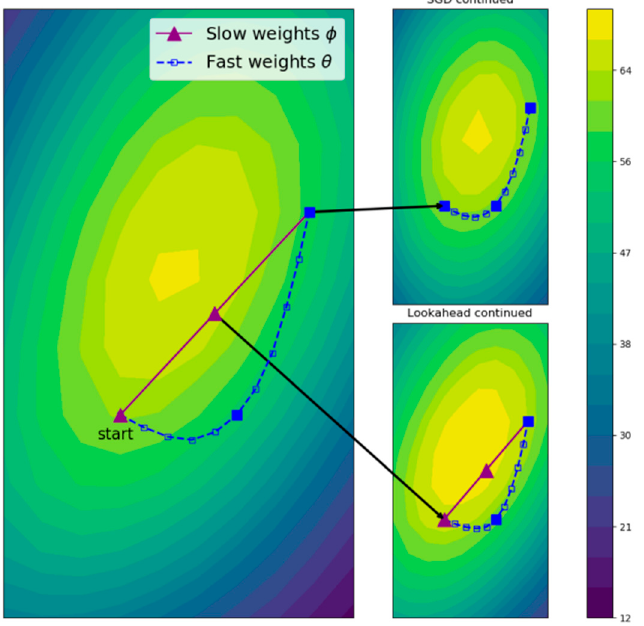
Figure 5. The visualization of Lookahead effects with k = 10 through a ResNet-32 test accuracy surface at epoch 100 on the CIFAR-100 dataset [15].